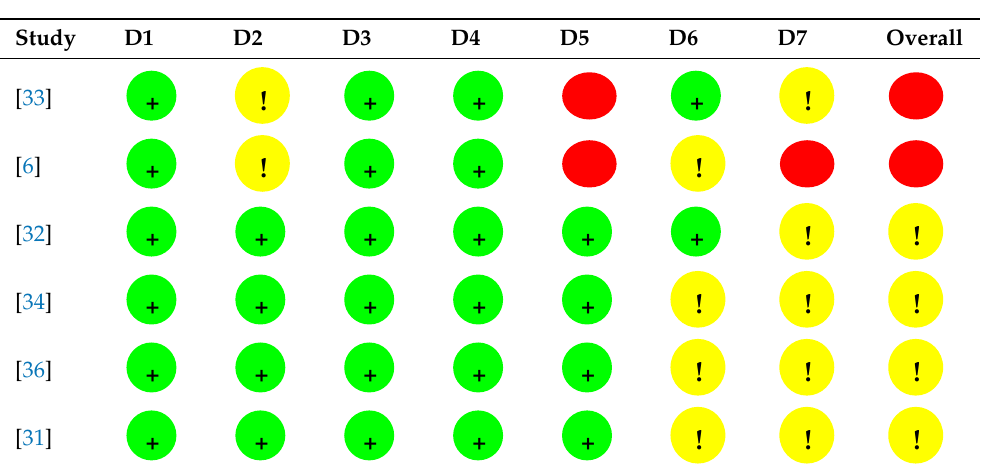
D1: reaching risk of bias judgements for bias due to confounding; D2: reaching risk of bias judg- ments in selection of participants into the study; D3: reaching risk of bias judgments for bias in classification of interventions; D4: reaching risk of bias judgments for bias due to deviations from intended interventions; D5: reaching risk of bias judgements for bias due to missing data; D6: reach- ing risk of bias judgements for bias in measurement of outcomes; D7: reaching risk of bias judgments for bias in selection of the reported result; Green (+): low risk; Yellow (!): moderate/serious risk; Red: critical risk.